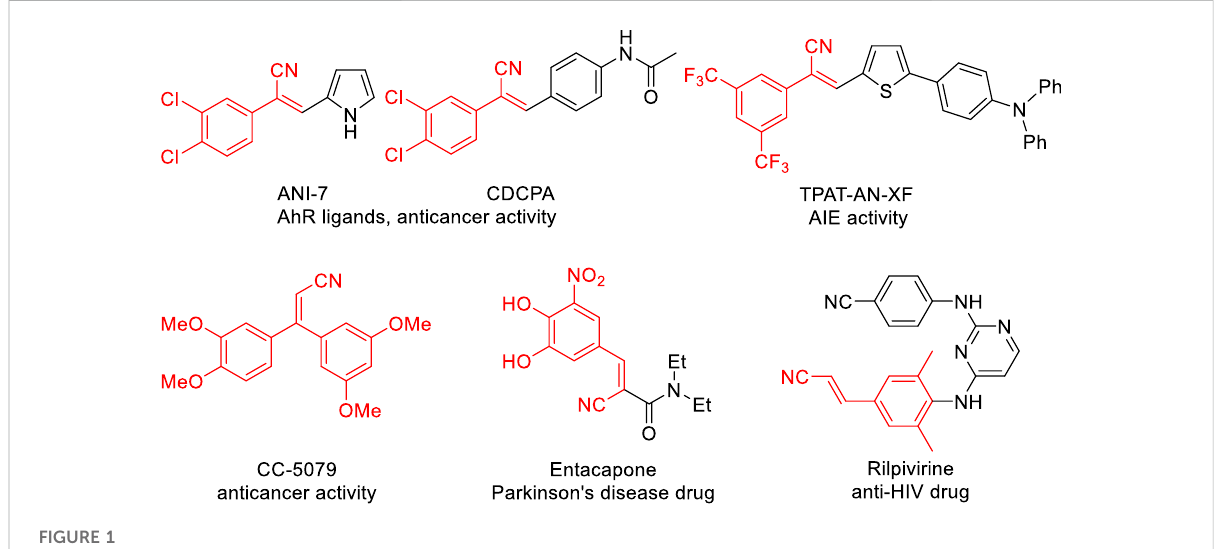
Representative examples of bioactive compounds with an aryl acrylonitrile.